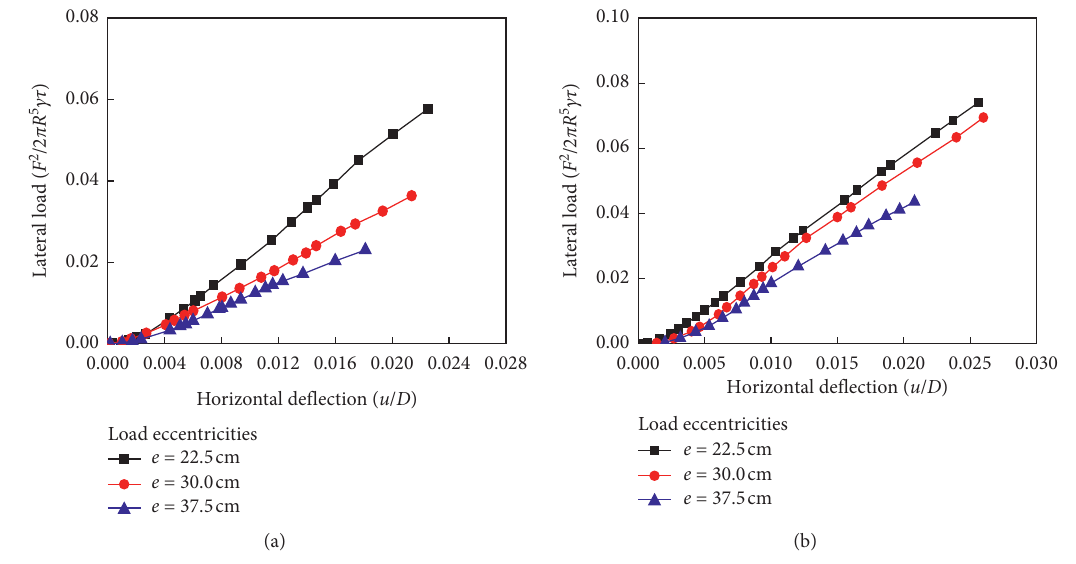
Figure 8: Effects of load eccentricities on lateral bearing capacity of CHFRF. (a) No. II-C. (b) No. II-D. Lateral load